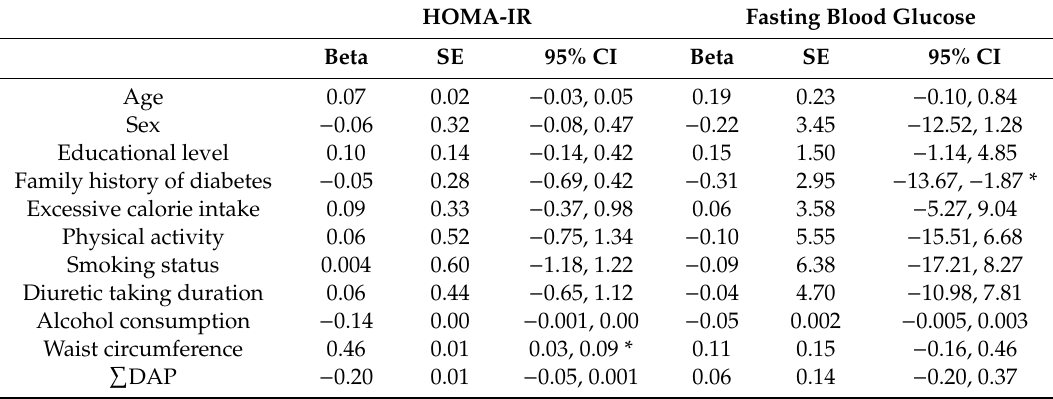
Factors associated with HOMA-IR and fasting blood glucose in sprayers and the general